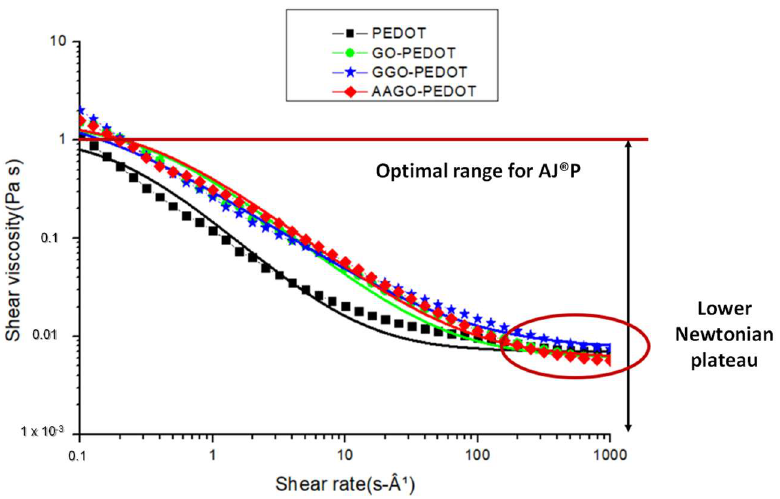
Figure 3. Comparison between rheological behaviour of PEDOT, GO-PEDOT, GGO-PEDOT and AAGO-PEDOT based inks and their fitting with Cross model. Moreover, the graph shows the optimum ink viscosity range for AJ ® P and the achievement of a lower Newtonian plateau around 1000 s −1 .